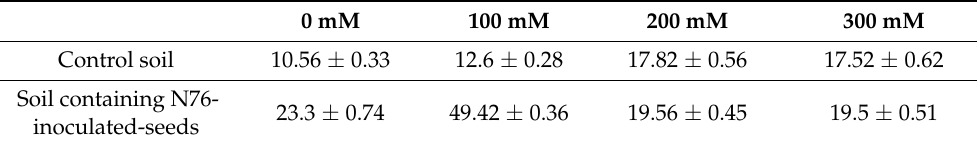
Table 3. The phosphorous availability (ppm) in control soil and soil containing inoculated seeds with Pseudomonas azotoformans